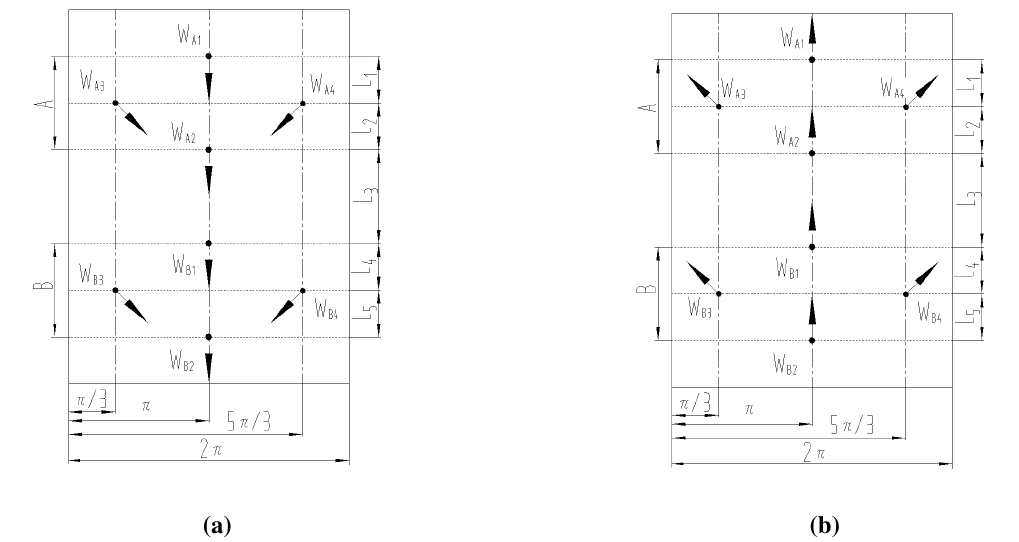
Fig. 6 Paths of the driving wheels along the double